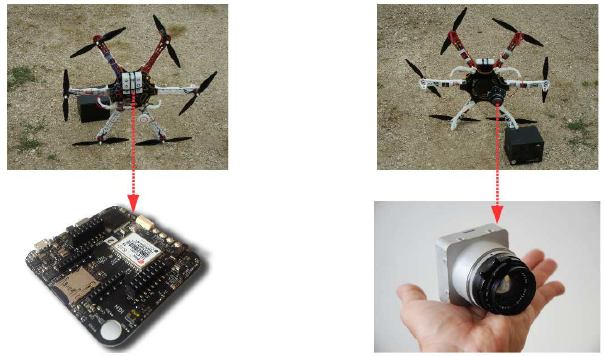
Figure 1: DJI-F550 UAV with IGN GeoCube (left) and on-board light camera